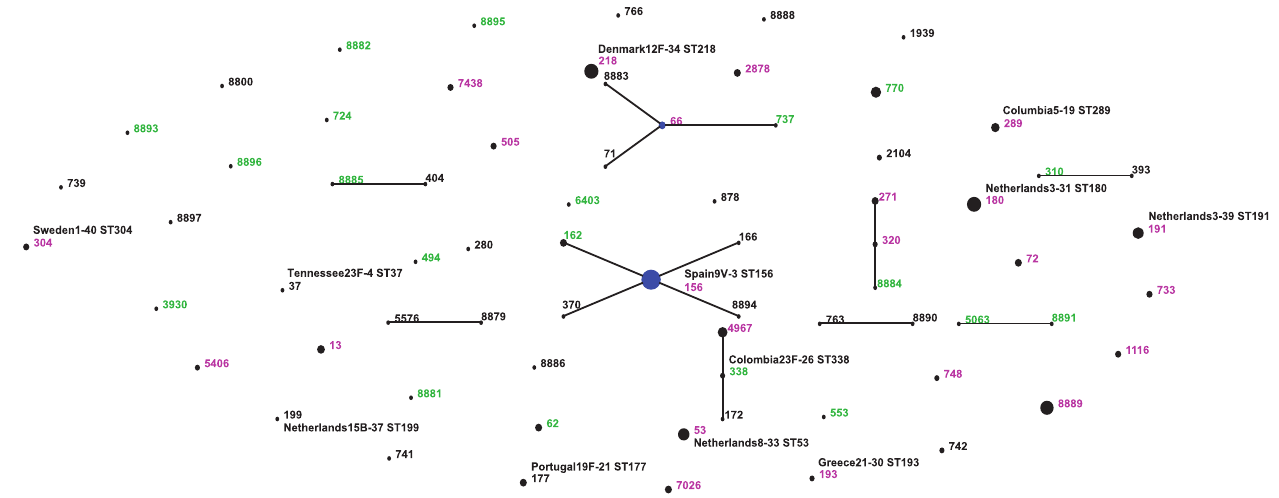
Figure 2. Population structure of invasive S.pneumoniae collected from 2007 to 2012. Black circles: pre-vaccine isolates; Green circles: post-vaccine isolates; pink circles: isolates present in both pre and post vaccine years; Blue circles: the ancestor of the CC.